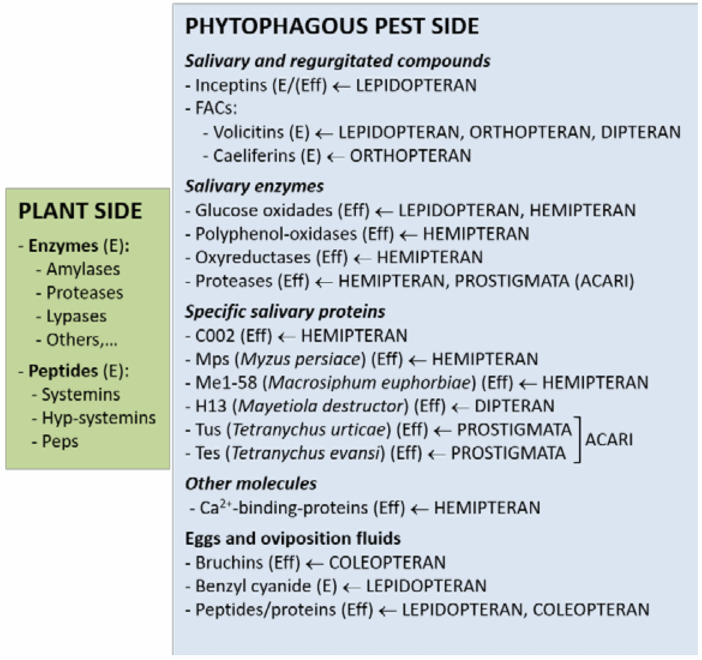
Figure 2. Elicitor (E)/effector (Eff) molecules from plant and phytophagous pest sides trigger, amplify, or suppress specific plant defense responses against pests. Phytophagous insect and acari species and orders are